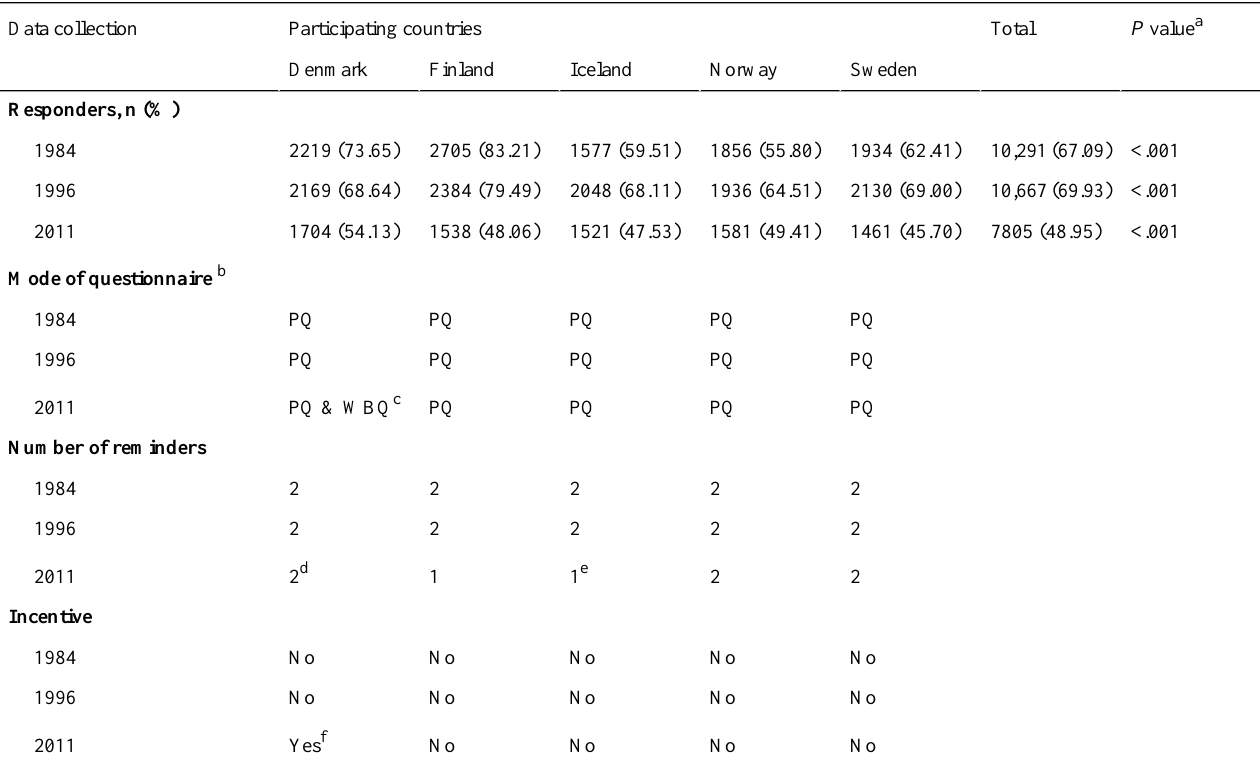
Table 4. The response rate and description of data collection for the 2011 NordChild questionnaire survey.